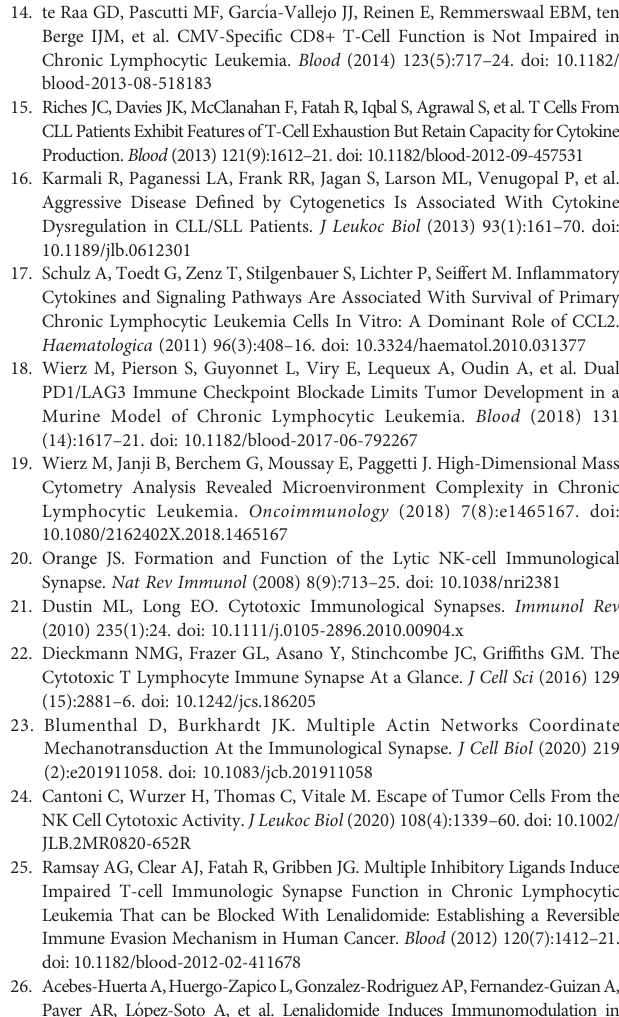
with and without an actin response following conjugation with NK cells. Image J software was used to do the quanti fi cation of LSM880 acquired images. Supplementary Figure 3 | (A) Imaging fl ow cytometry analysis of DMSO- or ZCL278-treated HG-3 and PGA-1 with regards to actin response frequency in conjugates. (B) Cytotoxicity assays of DMSO- or ZCL278-treated HG-3 and PGA-1 cells with NK-92MI at E:T ratio of 1:1 and 5:1. (C) Apoptosis assay of DMSO- or ZCL278-treated HG-3 and PGA-1 cells with NK-92MI effector cells. Cells were co- cultured for 45 minutes before live/dead staining with Annexin V and propidium iodide. (D) Quantitative imaging fl ow cytometry analysis ofgranzyme Bloadin HG-3 and PGA-1 CLL cells in conjugation with NK-92MI cells. (E) Imaging fl ow cytometry analysis of granzyme B load in DMSO- or ZCL278-treated HG-3 and PGA-1 CLL cells after 45 minutes of co-culture with NK-92MI cells. (F) Flow cytometry gating strategy for buffy coat-derived PBMC before and after negative selection for NK